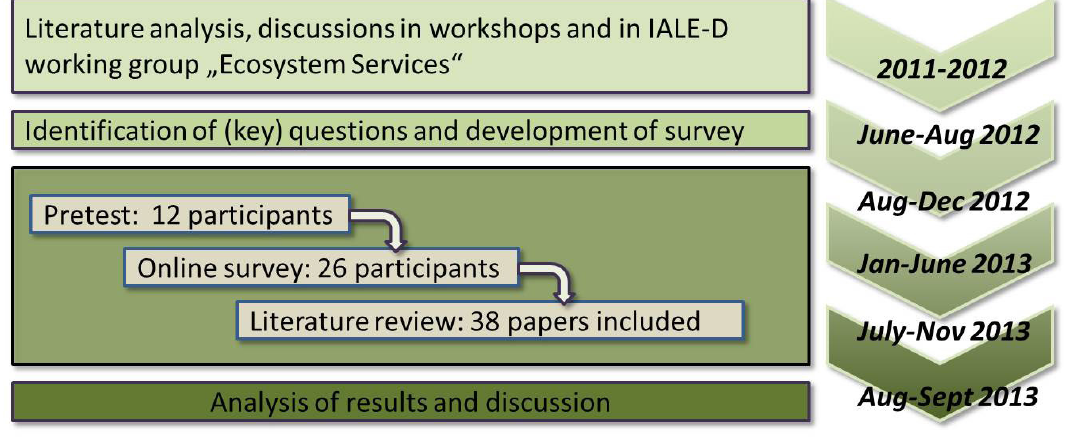
Figure 1: Overview of working